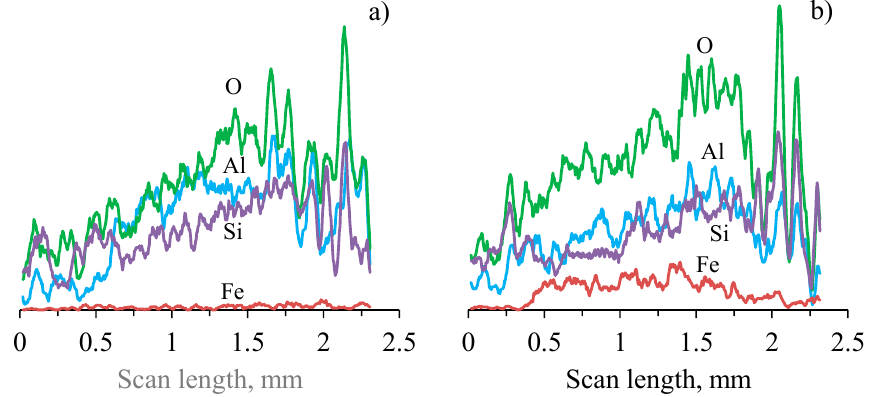
Figure 11. EDS analysis profiles (a.u.) for O, Al, Si, and Fe across wear scars on the PEO coating after different counterfaces for ( a ) WC-4%Co and ( b ) bearing steel. Table 3. Elemental composition of the wear scars for plasma electrolytic oxidation (PEO) coating for